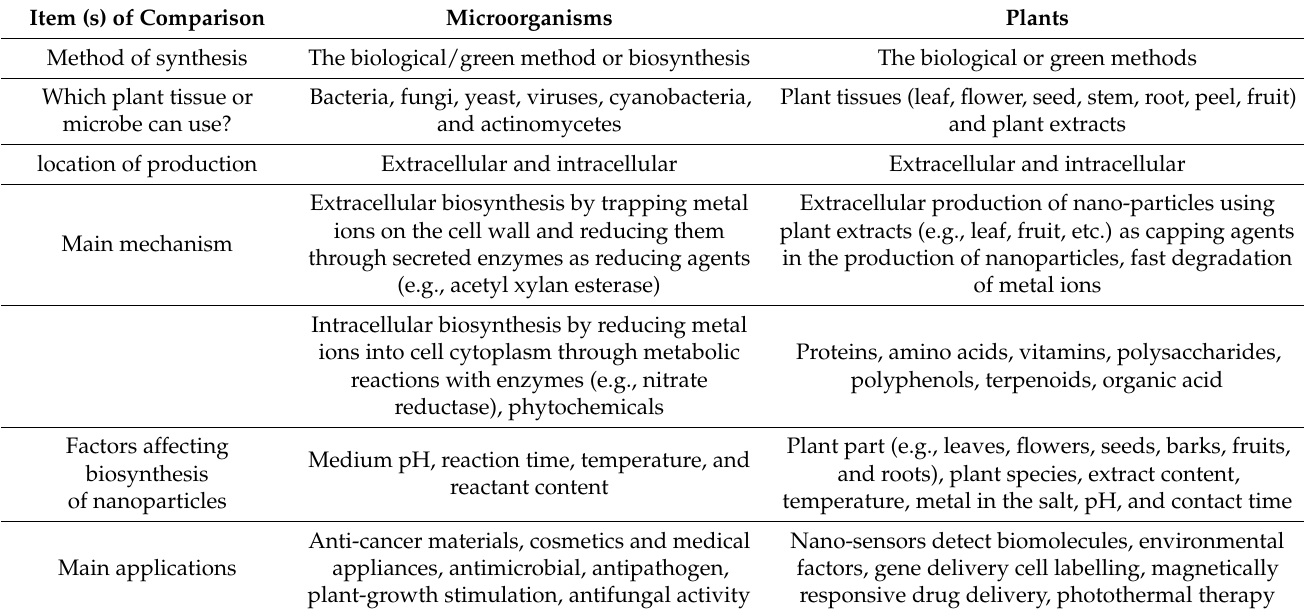
Table 2. A comparison between microbes and plants in producing